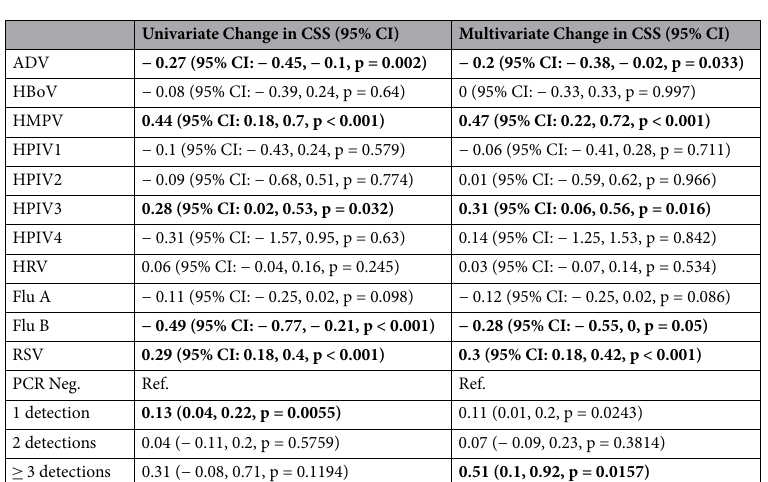
Table 4. Contributions to CSS by virus and number of virus detections. Table shows differences in CSS by virus detected estimated by regression with CSS as the outcome with viral detections as predictors. The first column is univariate (virus only) model, the second is the multivariate model (adjusted for age, sex, smoking inside the child’s home, SES, calendar year, month of year, daycare attendance, and breastfeeding status). For example, HMPV is associated with 0.51 (95% CI 0.22, 0.80, p < 0.001 ) higher CSS adjusted for the confounders. The bottom part of the table shows contributions to CSS by 1, 2, or ≥ 3 virus detections as compared to PCR negative patients. ADV Adenovirus, HBoV Human bocavirus, HMPV Human metapneumoviruses, HPIV-1, -2, -3, -4 Human parainfluenza viruses 1–4, HRV Human rhinovirus, Flu A influenza A, Flu B influenza B, RSV respiratory syncytial virus. Estimates displayed in bold face indicate statistical significance